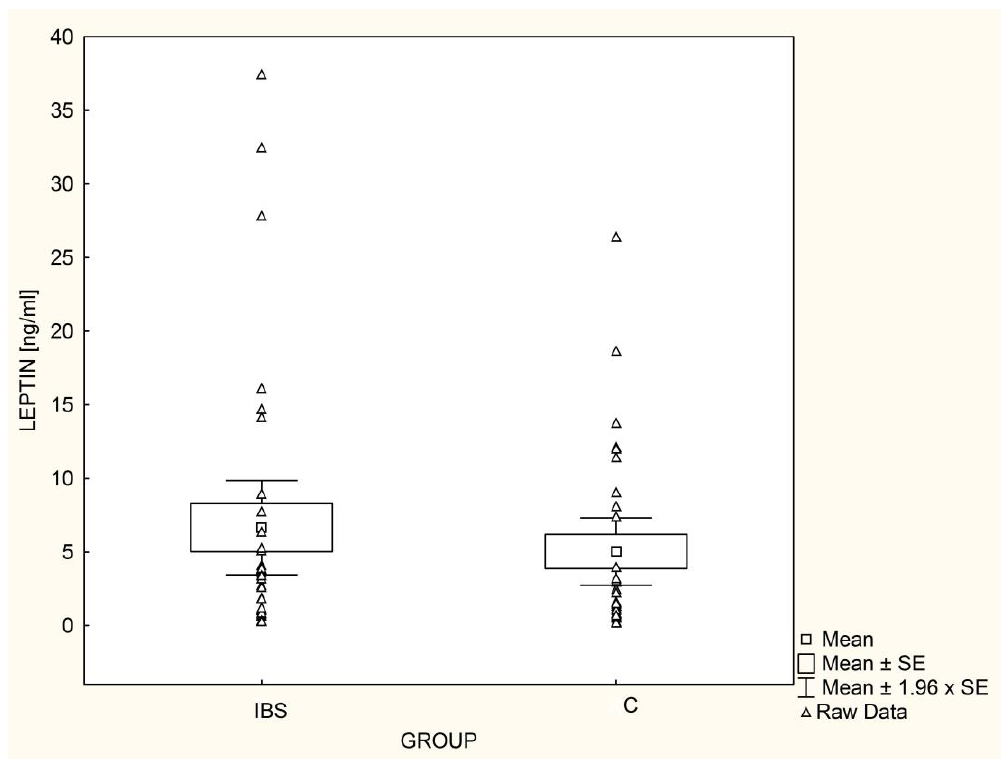
Figure 1. Mean leptin levels in children with irritable bowel syndrome (IBS; n = 33) and controls (C; n = 30).